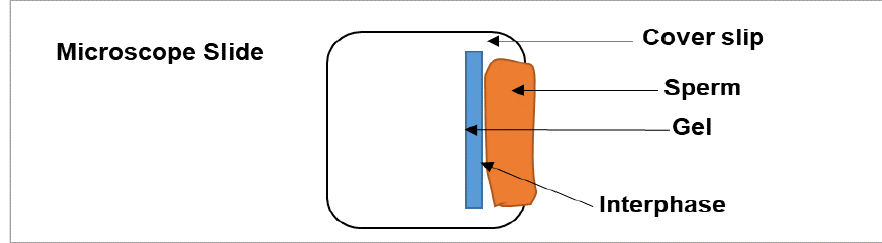
Figure 1. Schematic representation of the in vitro sperm penetration testing of the